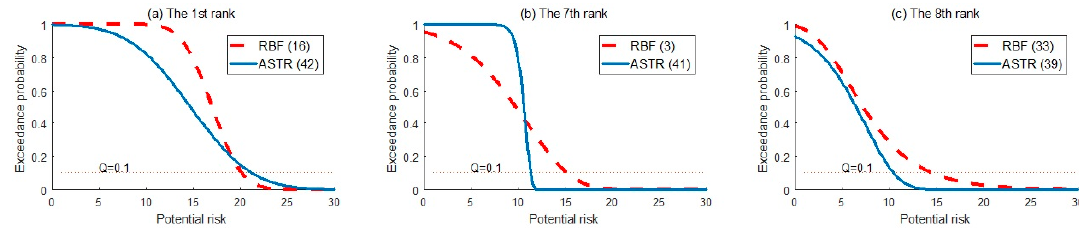
Figure 8. Comparison of exceedance probability distribution of cities in RBF and ASTR cases. ( a ) The 1st rank; ( b ) The 7th rank; ( c ) The 8th rank. 1st rank; ( b ) The 7th rank; ( c ) The 8th